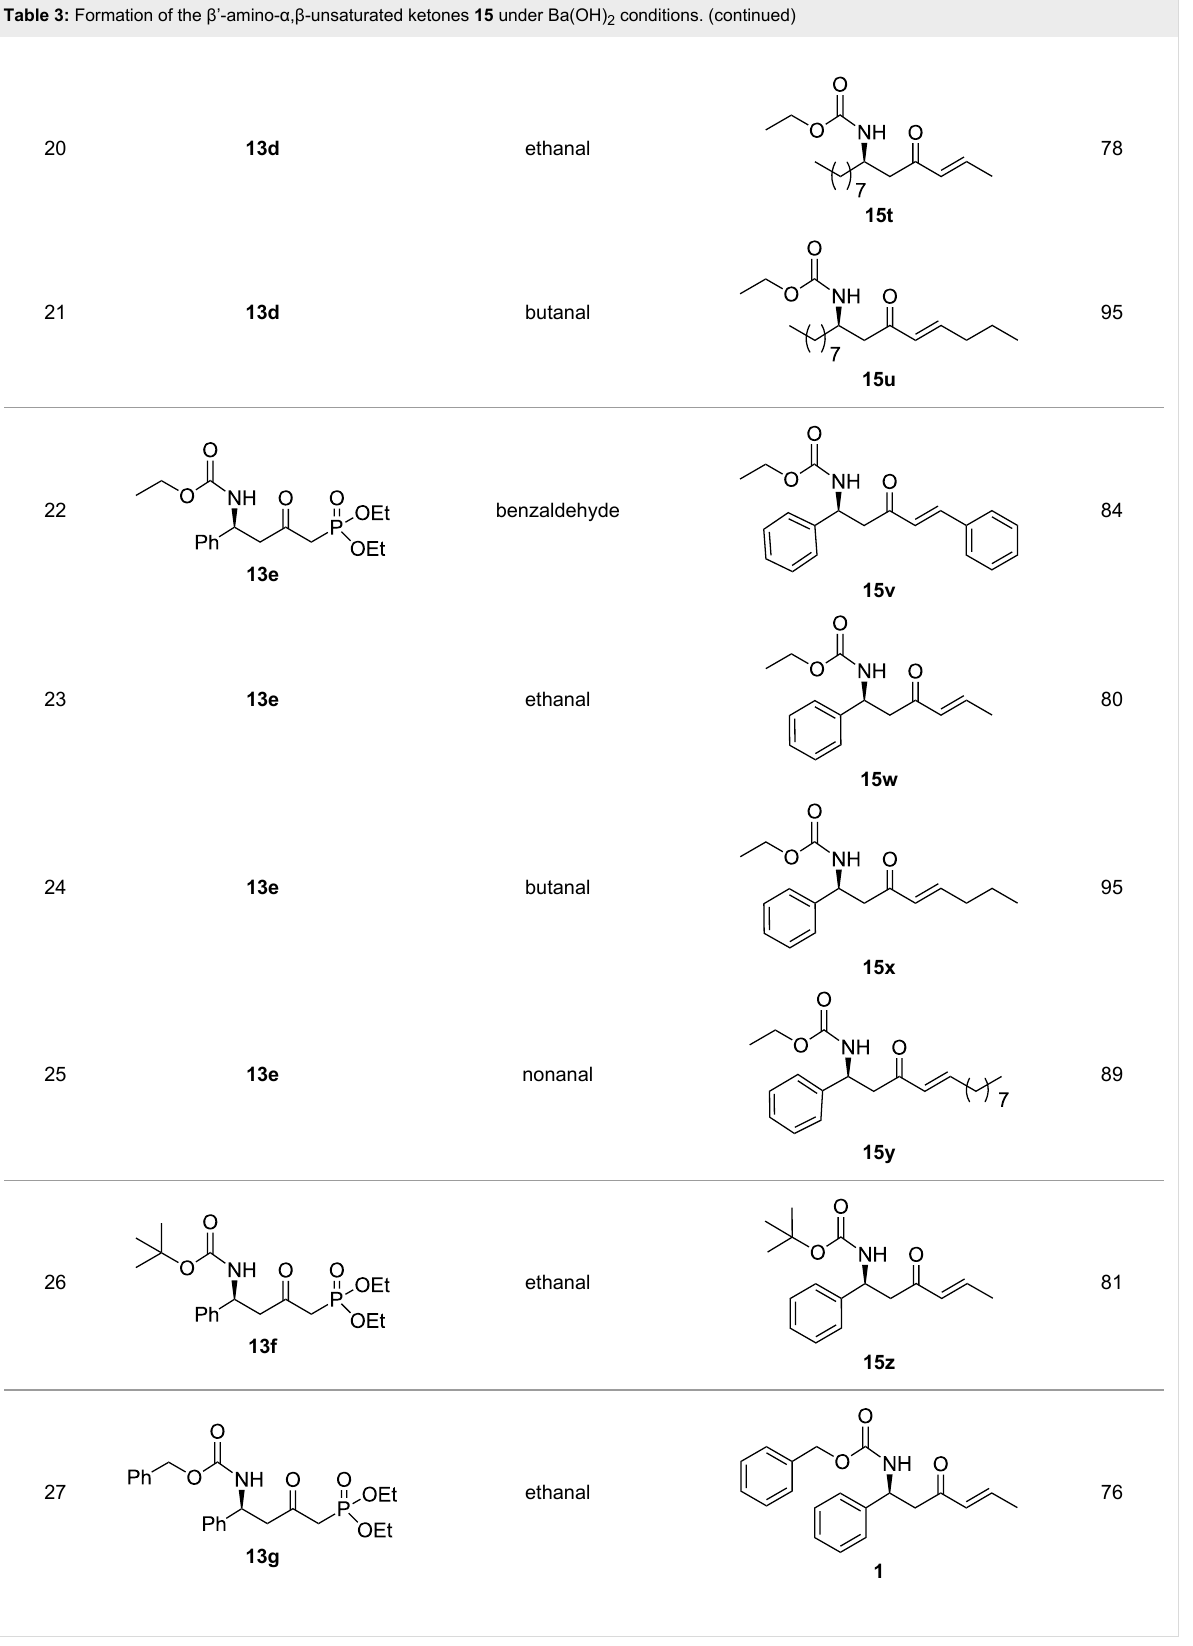
Table 3: Formation of the β ’-amino- α , β -unsaturated ketones 15 under Ba(OH) 2 conditions.